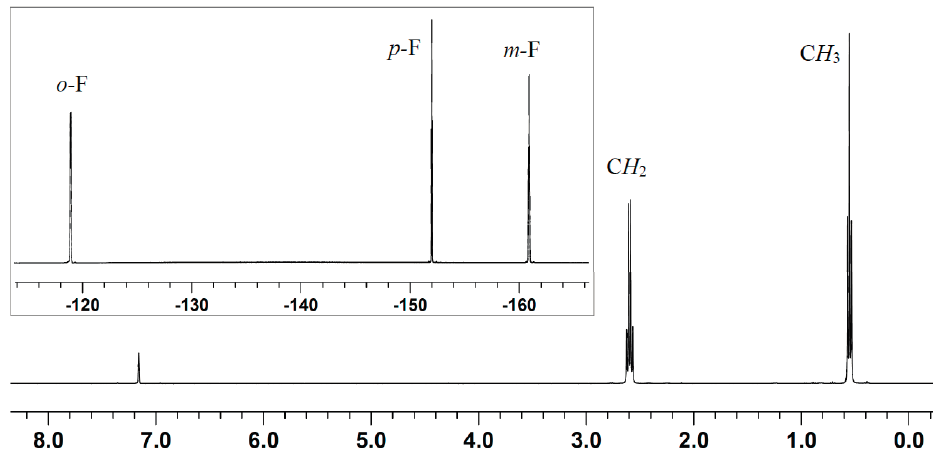
Figure 1. 1 H- and 19 F- (inset) spectra (C 6 D 6 ) of adduct Et 3 N · Al(C 6 F 5 ) 3 .